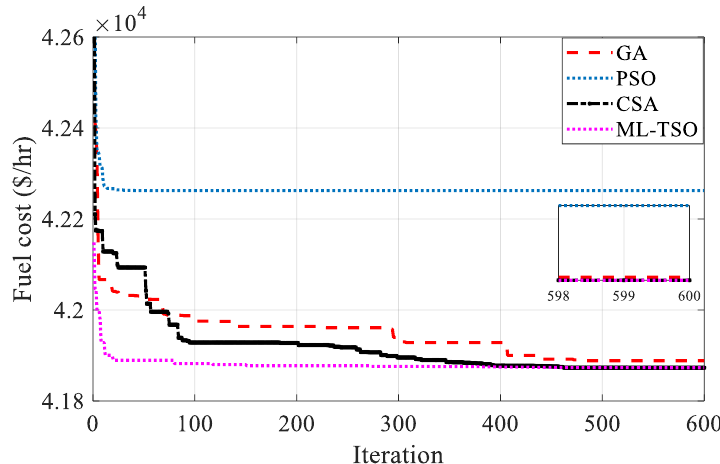
Figure 4. Convergence performance of the CSA, the GA, and the PSO in the case of the 57-bus system.